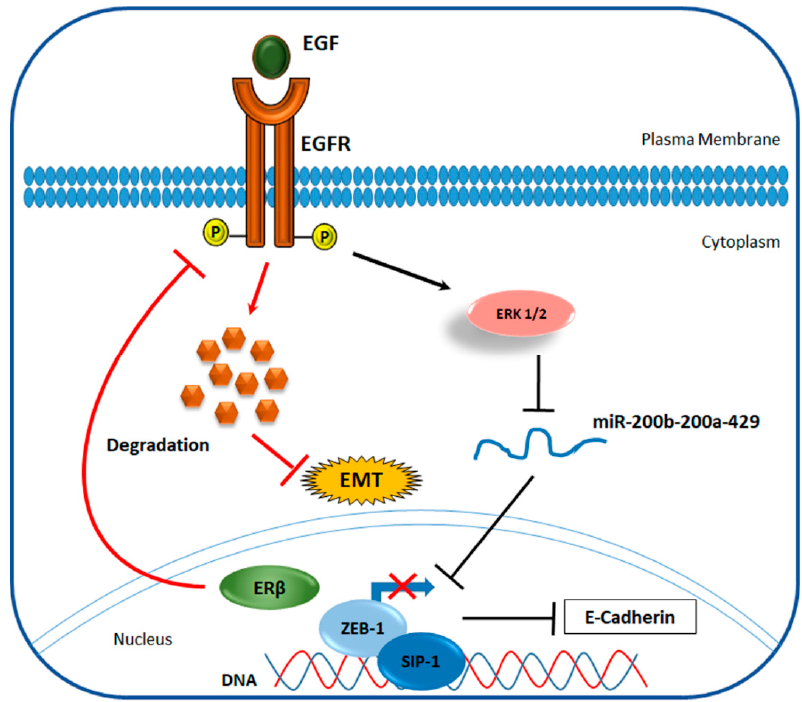
Figure 3. Proposed mechanism of ER β‐ mediated inhibition of EMT via EGFR degradation in TNBC. EGF (epidermal growth factor), through the interaction with its receptor (EGFR), promotes epithelial to mesenchymal transition (EMT) in BC cells. Generally, EGFR signaling leads to the phosphorylation